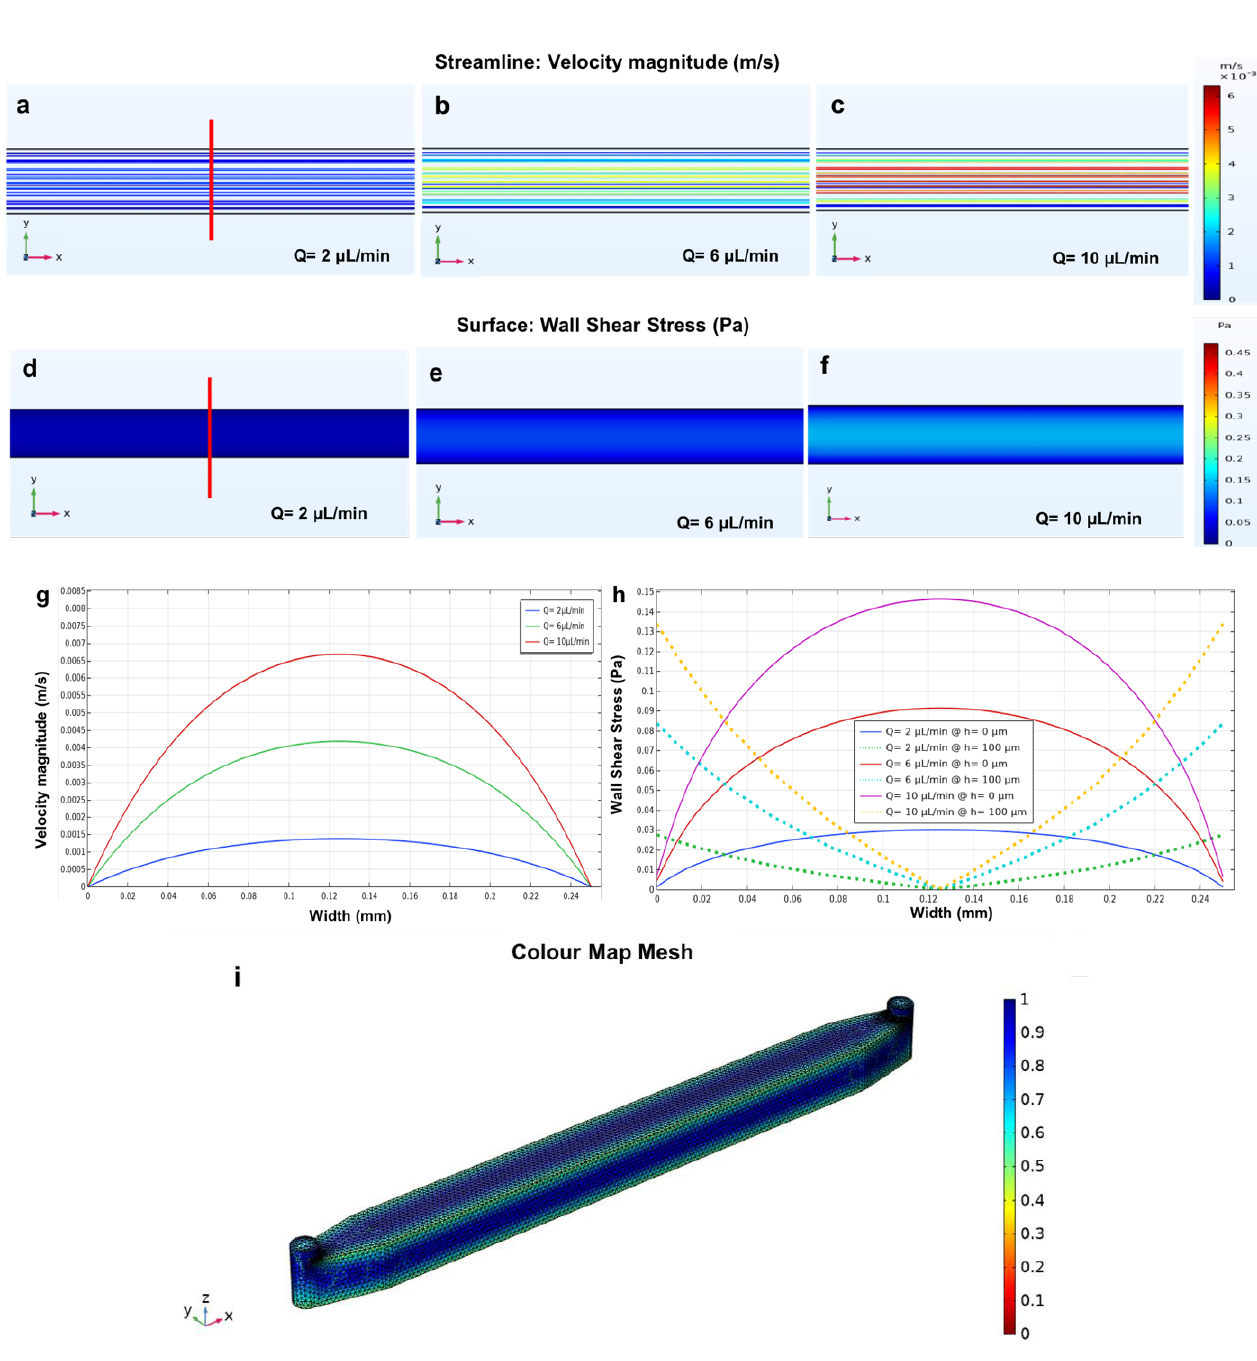
Figure 6. Simulated shear stress and velocity magnitude along the red line plotted versus the width of the microchannel using three different flow rates: 2, 6 and 10 µL/min. ( a – c ) fluid flow; ( d – f ) wall shear stress simulations of the longitudinal microchannel with a height of 200 µm; ( g ) the velocity profile; ( h ) wall shear stress profile at the bottom of the microchannel (h = 0 µm- solid lines) and at the middle of the microchannel (h = 100 µm- dotted lines); ( i ) generated mesh density study of the longitudinal microchannel.